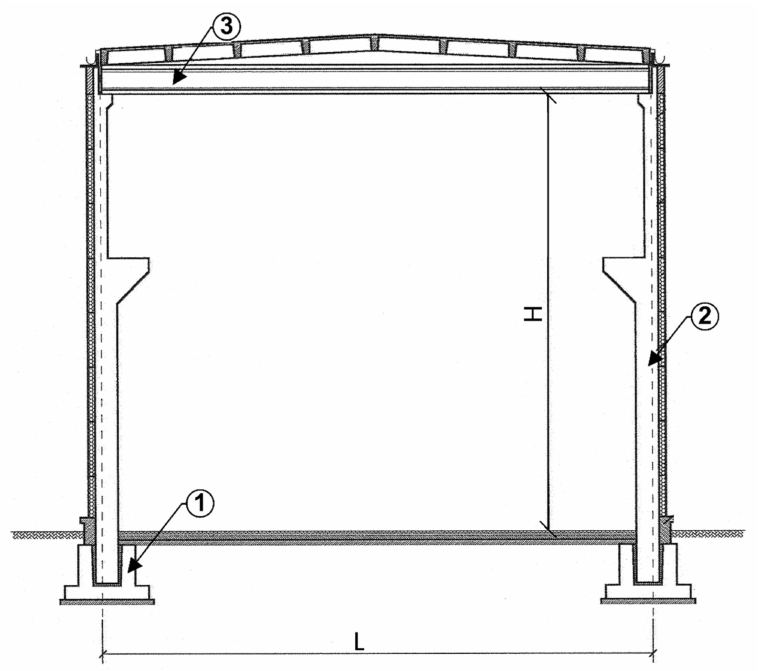
Figure 2. Cross-section of a single-nave hall building built on PF: 1,2,3,L,H, as in Figure